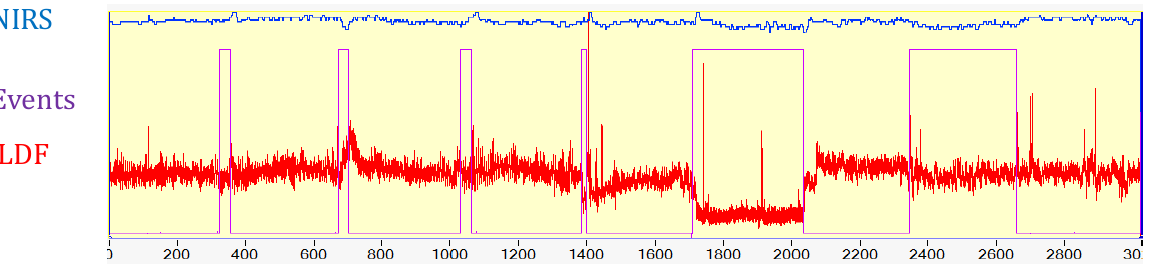
Fig. 6. Note the decrease of LDF flux signal during Trendelenburg position (1700-2050 sec). Also shown: LDF flux (red) and NIRS (blue) signals during all tests (purple). Y-axis is in AD conversion units; X-axis is in